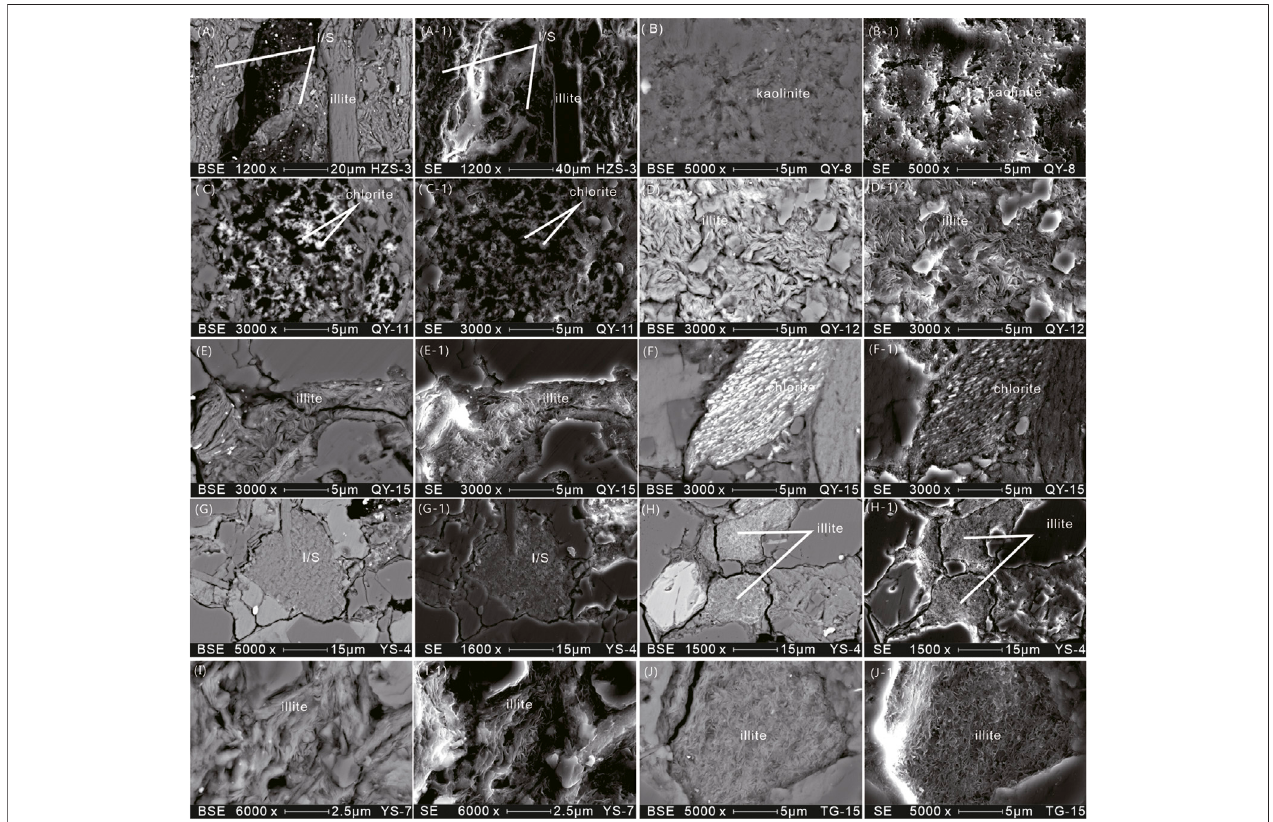
FIGURE 6 | The “ (A) ” represents BSE section photomicrographs and “ ( A -1) ” represents SE section photomicrographs, which are the same structure, and so are other pictures. (A) and ( A -1) illustrating textural features of cotton wadded I-S (R (cid:1) 3) and strip illite in Cambrian mudstone (HZS-3). (B) and ( B -1) illustrating textural features of vermicular porous kaolinite in maroon iron clay rock of the Carboniferous Hutian section (QY-8). (C) and ( C -1) illustrating textural features of blade chlorite in GrayishblackmudshaleoftheupperPaleozoicShiheziFormation(QY-11). (D) and(-1)illustratingtexturalfeaturesoffeatheryand fi lamentousilliteinGrayishblack silty mudstone of the upper Paleozoic Shihezi Formation (QY-12). (E) and (-1) illustrating textural features of feathery and bridged illite in the purple-red mudstone of LowerTriassicHeshanggouFormationofMesozoic(QY-15). (F) and(-1)illustratingtexturalfeaturesofneedle-shapedandlaminatedchloriteinthepurple-redmudstone of Lower Triassic Heshanggou Formation of Mesozoic (QY-15). (G) and (-1) illustrating textural features of cotton wadded I/S (R (cid:1) 3) in mudstone of the Lower Triassic Heshanggou Formation ofMesozoic(YS-4). (H) and (-1) illustrating textural features of ribbon-packed, strip-shaped illite inmudstoneof theLower Triassic Heshanggou FormationofMesozoic(YS-4). (I) and(-1)illustratingtexturalfeaturesofroseateilliteinpurplemudstoneoftheMiddleTriassicErmayingFormationofMesozoic(YS-7). (J) and (-1) illustrating textural features of fi lamentous and feathery illite in purple mudstone of the Upper Triassic Yanchang Formation of Mesozoic